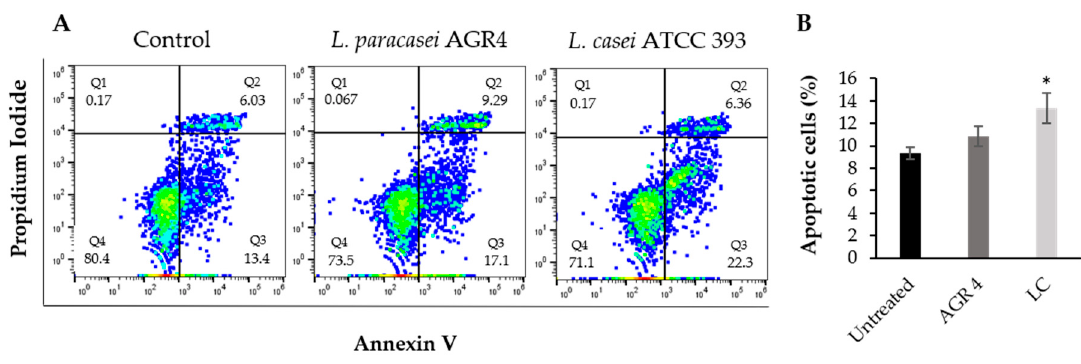
Figure 6. Assessment of the pro-apoptotic potential of L. paracasei AGR 4 via flow cytometry. HT-29 cells were co-incubated with 10 7 CFU / mL of Lactobacillus AGR 4 or L. casei ATCC 393 (LC) for 48 h. Untreated cells incubated with culture media were used as control. ( A ) Representative flow cytometry scatter plots. Q4: live cells; Q3: early apoptotic cells; Q2: late apoptotic cells; Q1: dead cells and debris. The percentage of cells in each quadrant is also shown. ( B ) Quantitative analysis of two independent experiments. * p < 0.05 compared to the untreated cells.